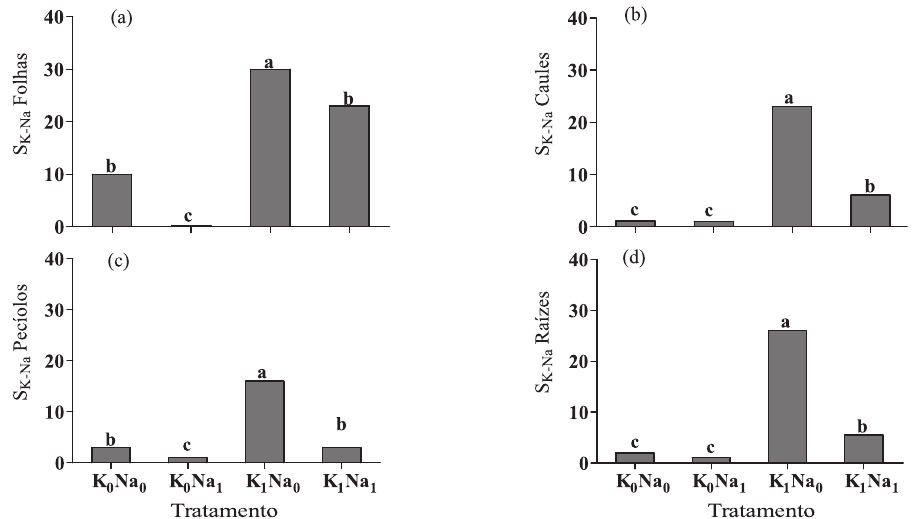
figura 3. seletividade de K-na em (a) folhas, (b) caule, (c) pecíolos e (d) raízes de pinhão-manso submetido a diferentes concentrações externas de K e na por um período de oito dias. K 0 : ausência de potássio; K 1 : 10 mmol l -1 de K; na 0 : ausência de sódio; e na 1 : 50 mmol l -1 de na na solução nutritiva. os valores representam médias de cinco repetições. médias iguais seguidas de letras minúsculas não denotam diferenças significativas, conforme o teste de Tukey (p < 0,05).